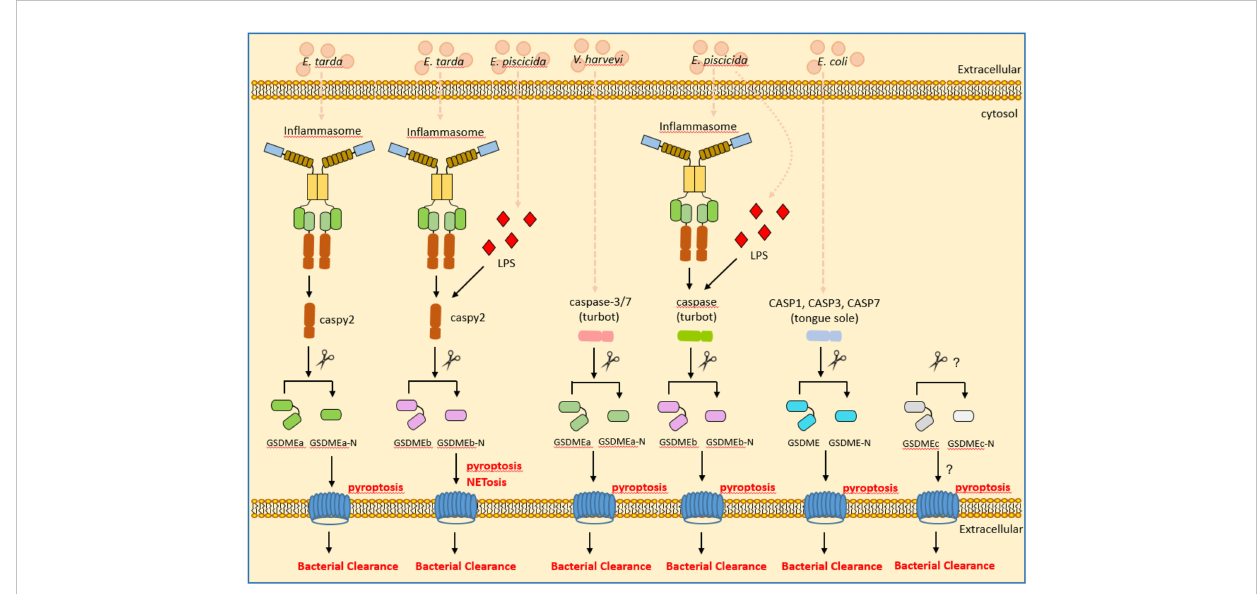
FIGURE 4 The roles of piscine GSDME in in fl ammasome signaling, pyroptosis and bacterial clearance. GSDME mediates pyroptosis following cleavage by in fl ammatory caspases. In the zebra fi sh and turbot, GSDMEa and GSDMEb were obtained. Zebra fi sh caspy2 cleaves GSDMEa/b for resulting in pyroptosis and bacterial clearance of E. tarda or E. piscicida . Turbot caspase-3/7 cleave GSDMEa for resulting in pyroptosis and bacterial clearance of V. harveyi . The in fl ammatory caspase in the turbot cleaves GSDMEb for resulting in pyroptosis and bacterial clearance of E. piscicida . In the tongue sole, CASP1, CASP3 and CASP7 cleave GSDME for resulting in pyroptosis and bacterial clearance of E. coli